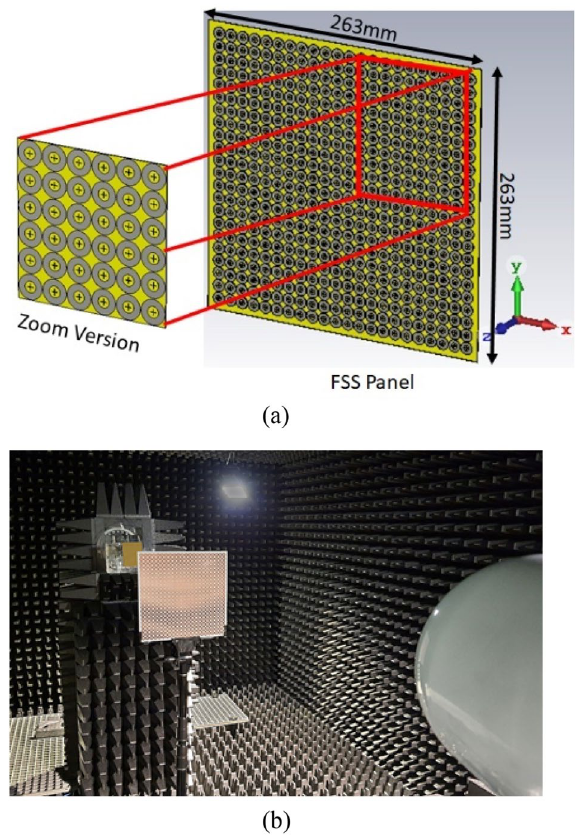
Figure 11. FSS panel of Design 1, ( a ) CST simulated environment and ( b ) measurement setup.